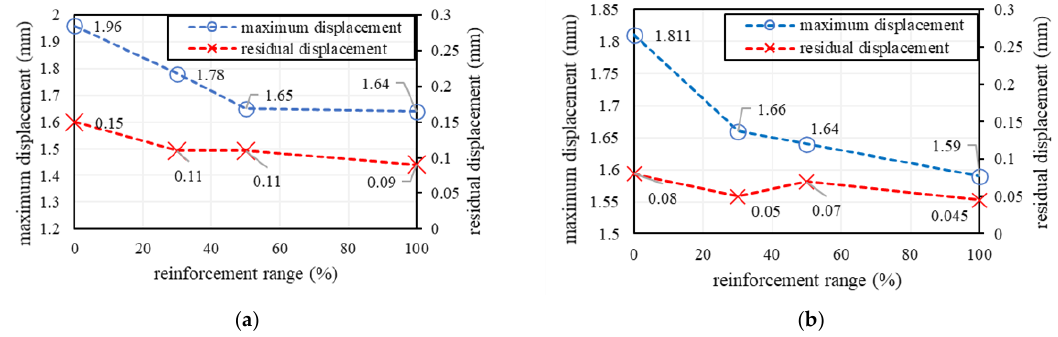
Figure 31. Comparison of maximum displacement and residual displacement of TYPE-C: ( a ) wave A; ( b ) wave B.